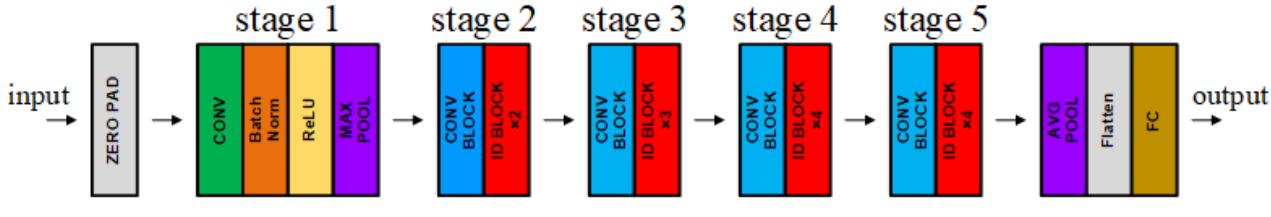
Figure 3. The ResNet-50 Block Architecture [20].